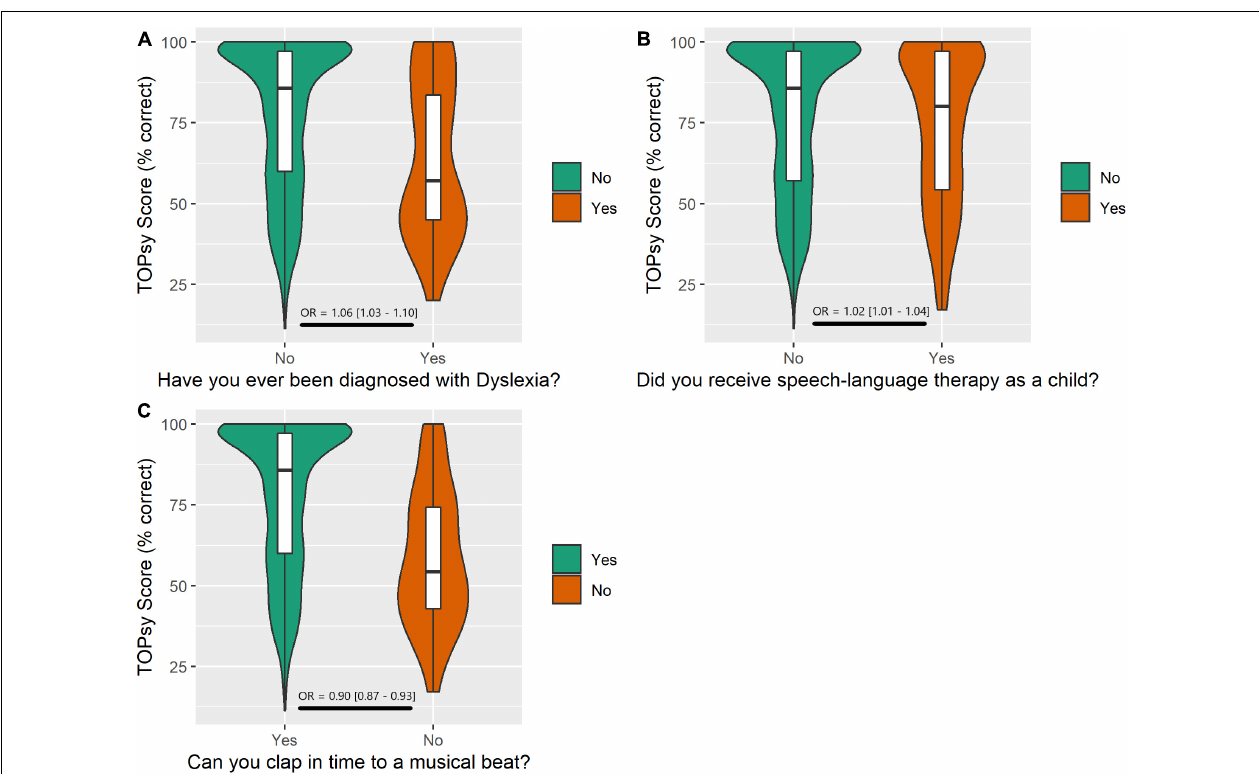
FIGURE 2 | Comparative distributions of lexical stress perception scores on the 28-item TOPsy are illustrated. The right side of plots (A–C) illustrate distributions in those who reported a dyslexia diagnosis (i.e., reading difficulties), receiving speech-language therapy in childhood (i.e., speech-language difficulties), or not being able to clap in time with a beat (i.e., musical rhythm difficulties) respectively. The left side of each plot illustrates distributions in those who reported no difficulties on self-report